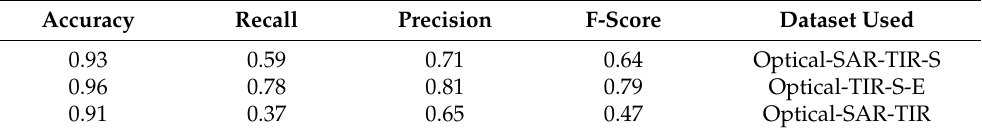
Table 2. Results of the proposed deep artificial neural network (SGDNet) model using a combination of optical, thermal, coherence, and slope as input